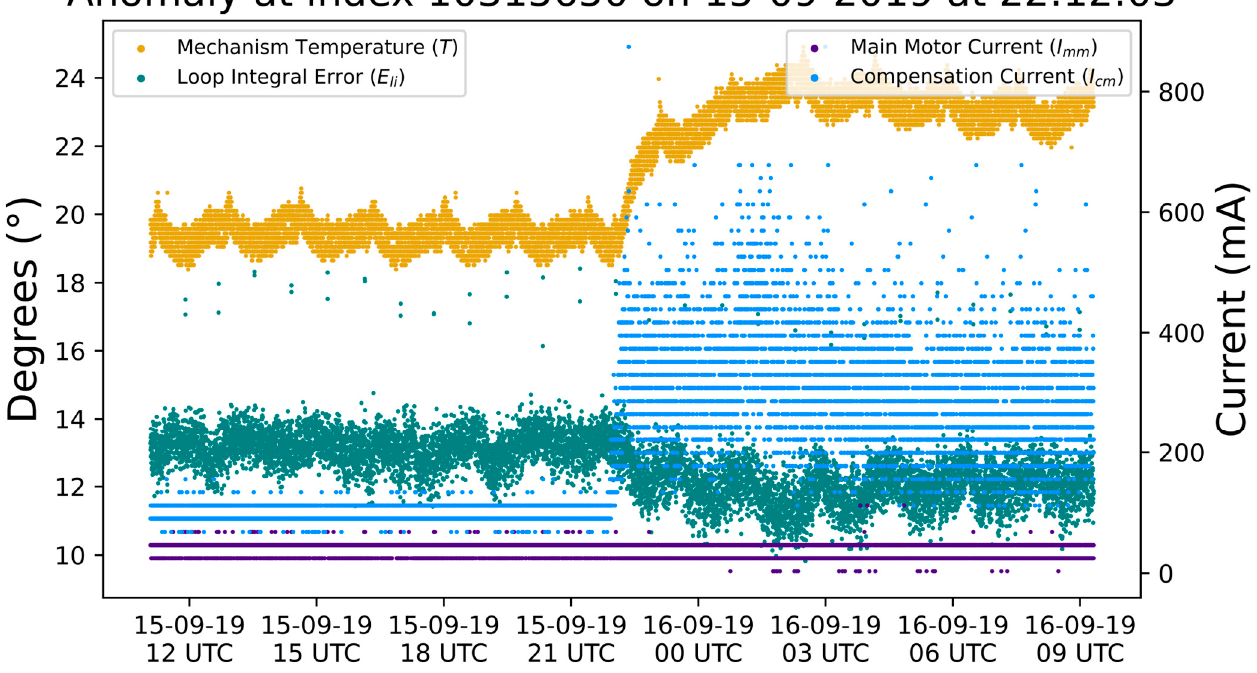
Figure 9. An example of a small increase in T that is correlated more strongly with I cm than I mm